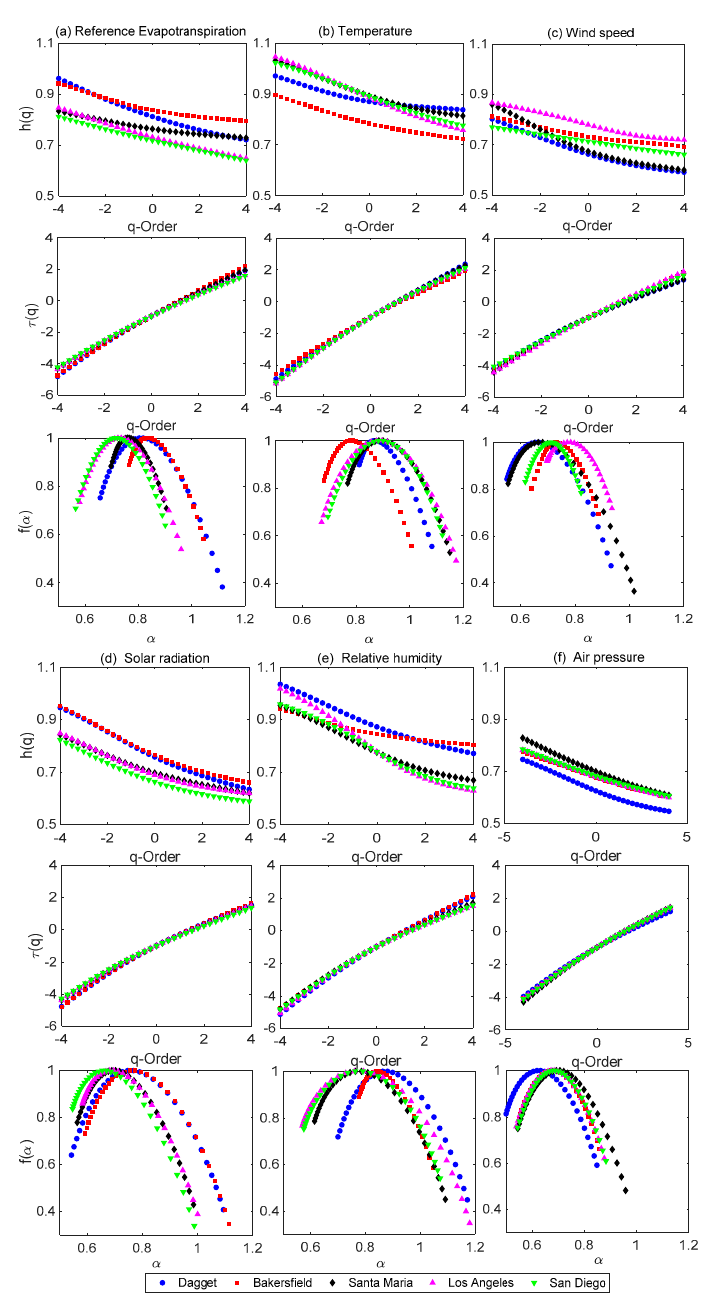
Figure 4. Multifractal plots of different agro-meteorological time series: ( a ) reference evapotranspiration; ( b ) temperature; ( c ) wind speed; ( d ) solar radiation; ( e ) relative air humidity; and ( f ) air pressure. The upper panels show the GHE plots, middle panels show the mass exponent plots and lower panels show the multifractal spectra.